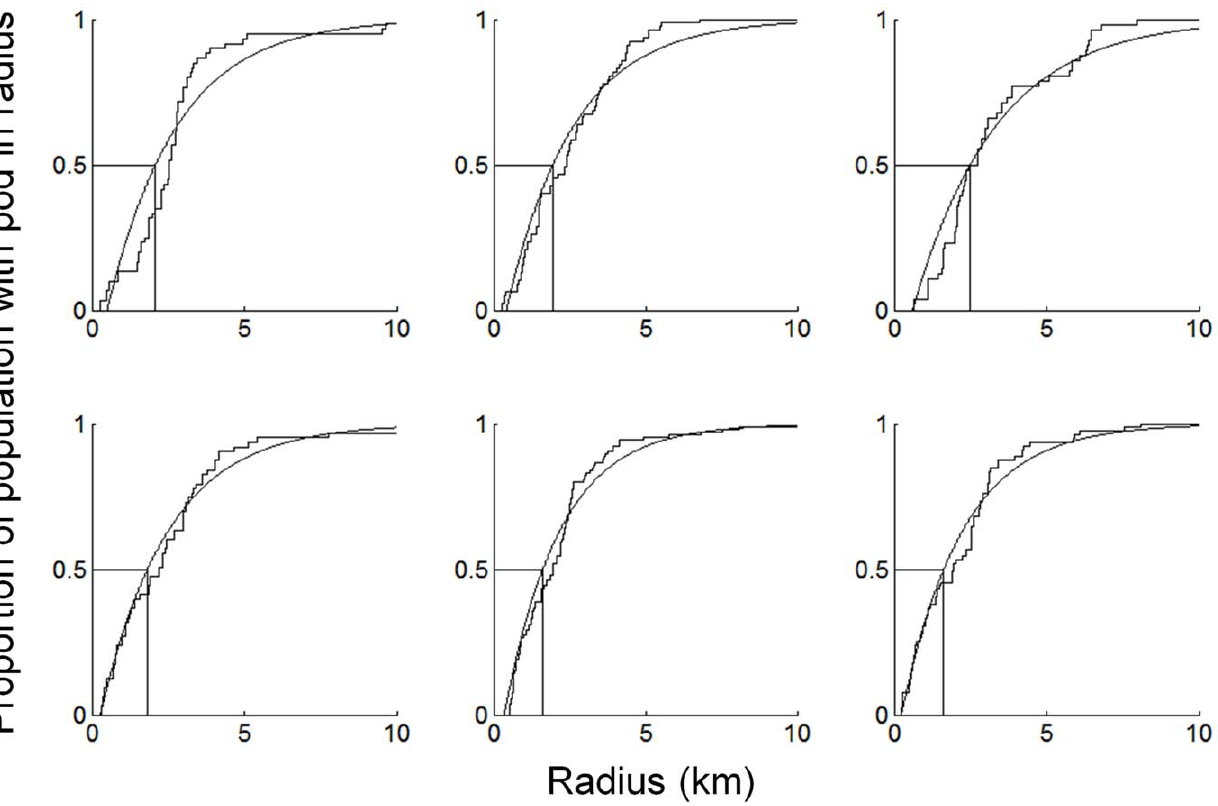
Figure 7. The proportion of the population with a pod within a fixed radius, and increasing radii. Cumulative density plots of the proportion of population that have at least one pod within a specified radius, at increasing radii, for A) flight 1, B) flight 2, C) flight 3, D) flight 7, E) flight 9, and F) flight 10. Each plot was fit with an exponential curve using the least squares method, and the radius at which half the population have a pod within this radius was calculated from the curves. Theses radii are A) 2.09 km, B) 1.95 km, C) 2.50 km, D) 1.82 km, E) 1.61 km, and F) 1.62 km.